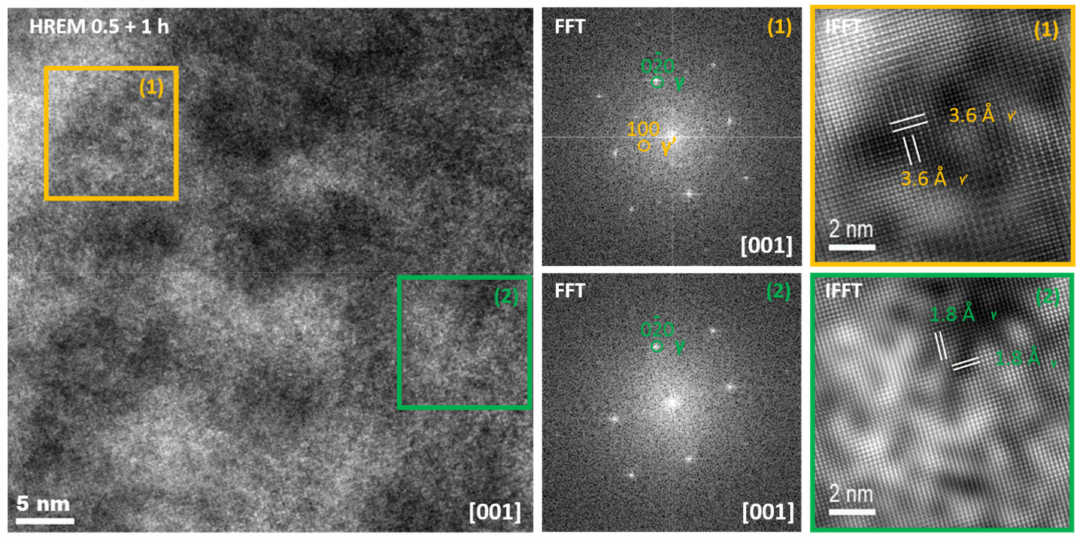
Figure 4. HRTEM image and corresponding FFT and IFFT images of the material aged at 973 K for 0.5 h and 1 h at 723 K.